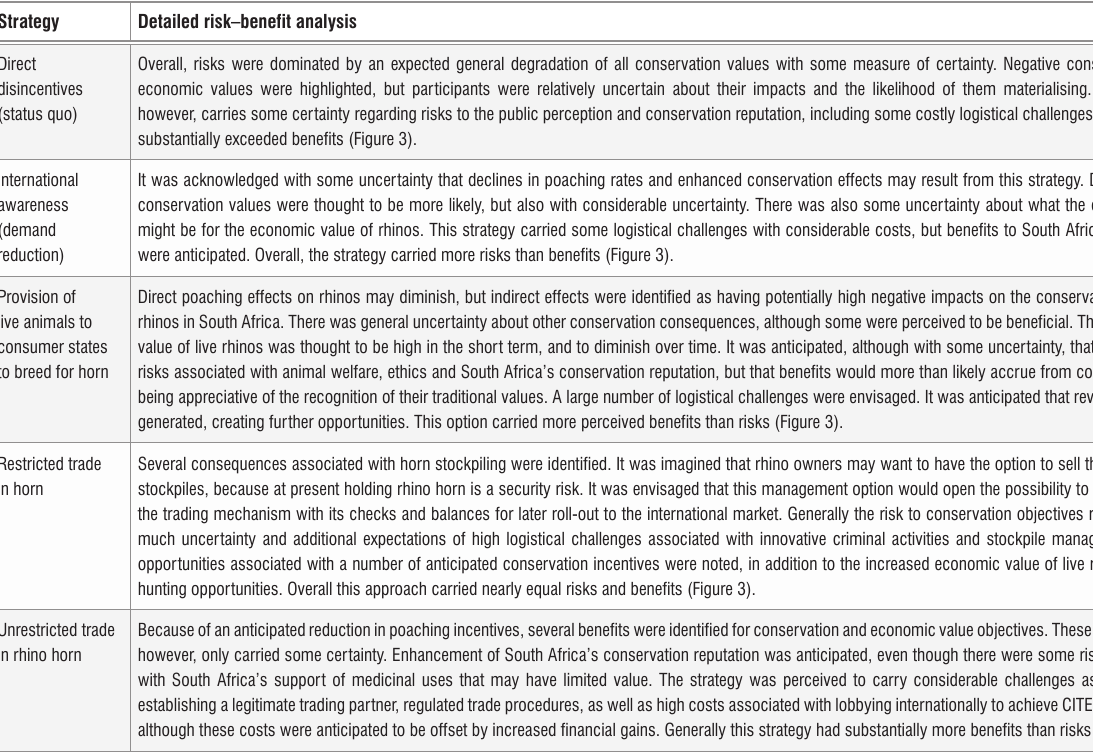
Table 4. The descriptions include each strategy’s logistical challenges and opportunities, and relative financial costs and revenue